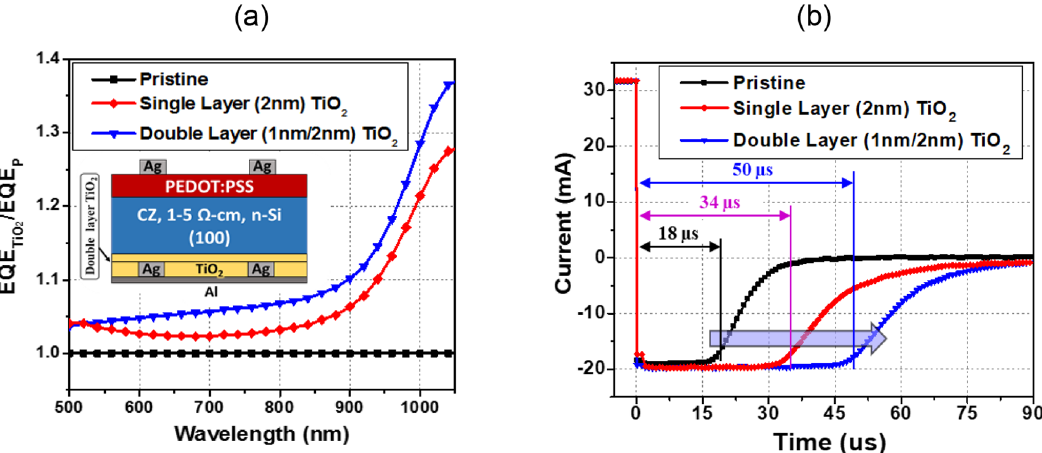
Fig. 6. (a) Normalized EQE, EQE TiO2 /EQE pristine and (b) T rr current pro fi les of PEDOT:PSS/n-Si heterojunction solar cells with single- and double-layer of 2-nm-thick TiO 2 HBLs including the recovery time for each